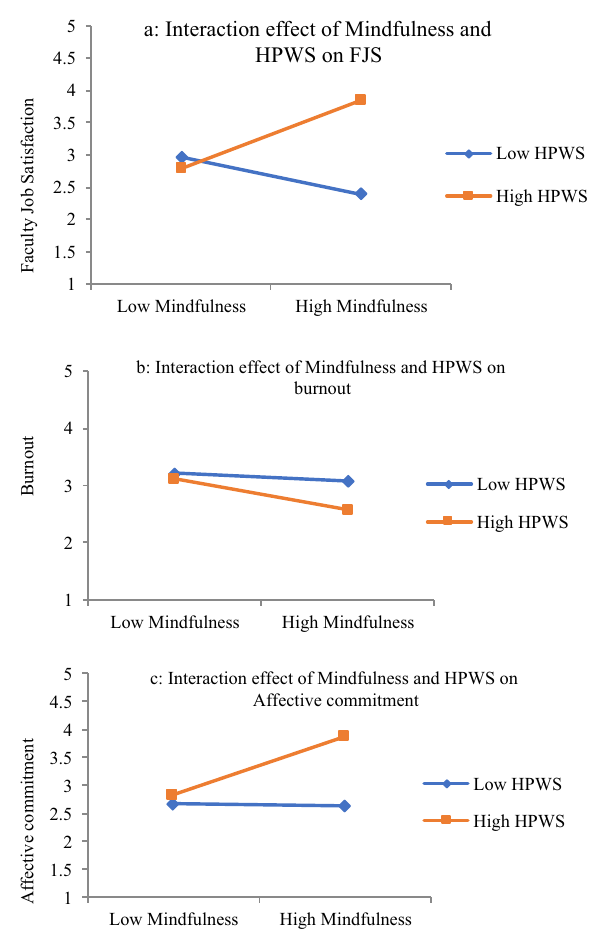
Fig. 2 Interaction effect mindfulness and HPWS on outcome variables. a Interaction effect of Mindfulness and HPWS on FJS. b Interaction effect of Mindfulness and HPWS on burnout. c Interaction effect of Mindfulness and HPWS on Affective